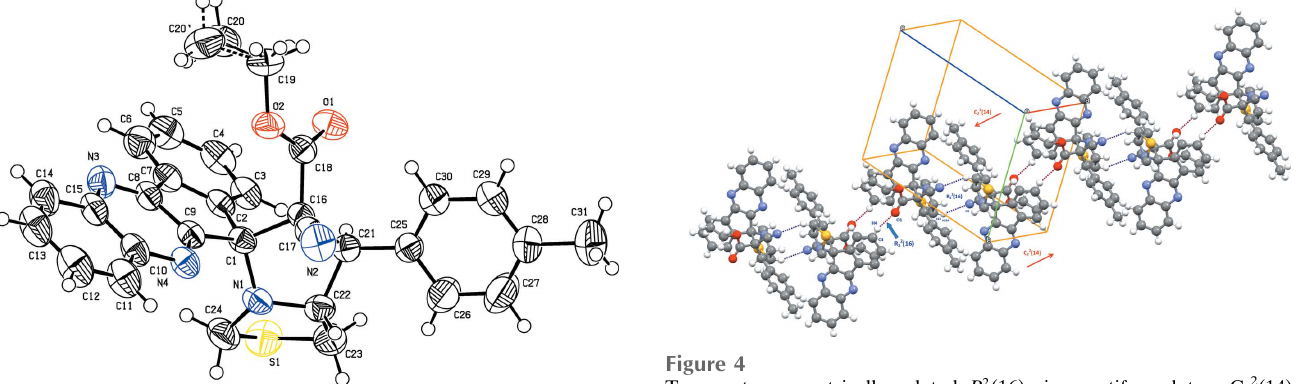
Figure 1 The asymmetric unit of the title compound with atom-numbering scheme and 50% probability displacement ellipsoids. The –CH 3 group (C20) is disordered over two positions with site occupancies of 0.55 and